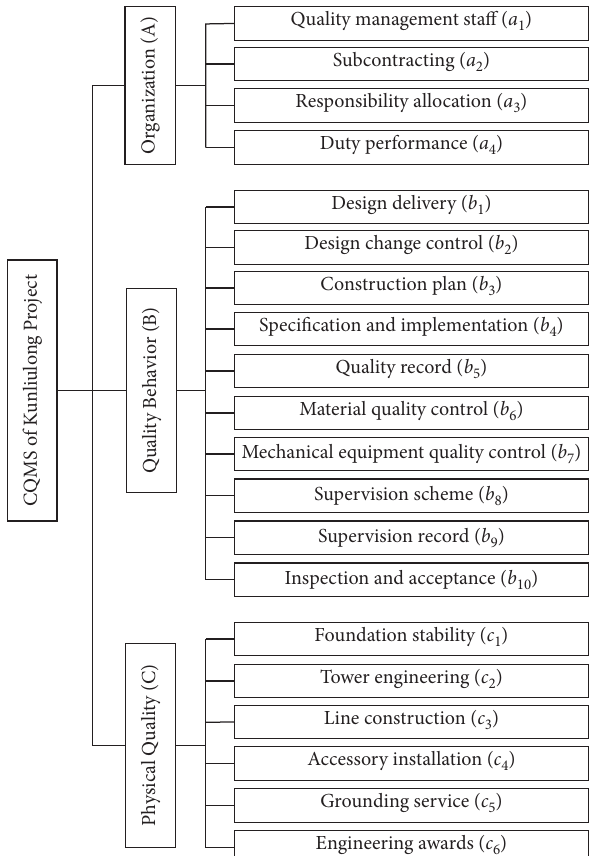
Figure 3: Evaluation index system of the Kunliulong DC Project